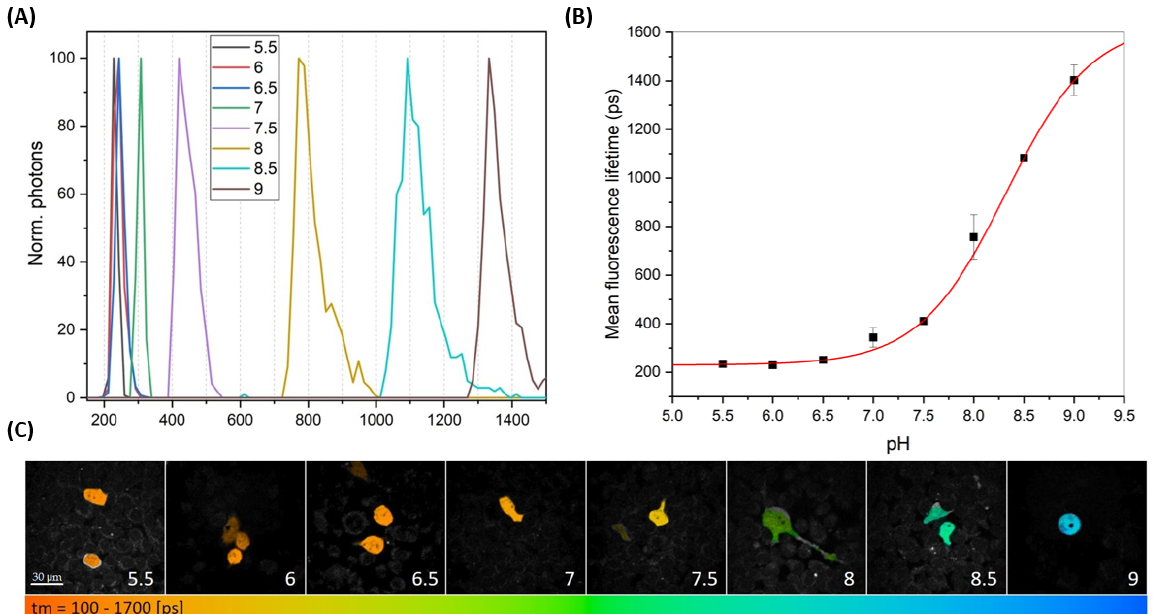
Figure 3. FLIM data recorded from the monensin/nigericin-penetrated HEK293T cells expressing EGFP-Y145L/S205V, pre-incubated with pH buffers (pH 5.5–9.0). ( A ) Histograms showing the mean lifetime distribution calculated from the FLIM scans at different pH values (color legend is in the inset). ( B ) The graph describing the dependence of the mean lifetime on the pH. ( C ) Color-coded FLIM scans exemplifying the lifetime values recorded in the cytoplasm of the HEK293T cells (color legend is under the image gallery). Scale bar is 30 µm. A two-photon (2P) laser, λ em = 750 nm, was used for the fluorescence excitation.